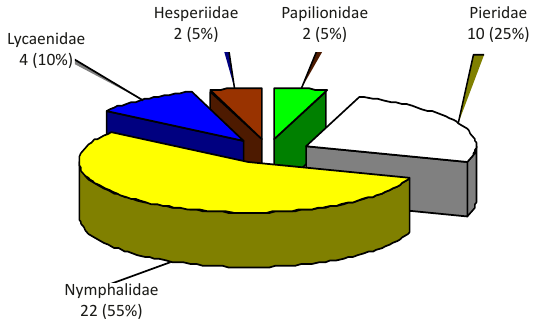
Figure 1. Family-level classification of butterfly species in Kathlaur- Kaushlian Wildlife Sanctuary, Punjab (n = 40spp)